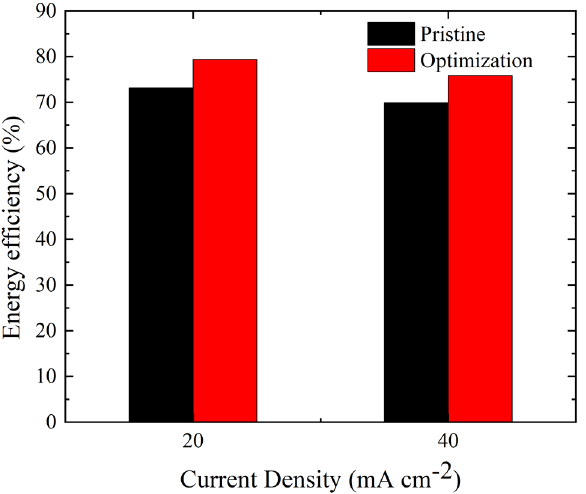
Figure 18. Comparison of energy e ffi ciency of ba tt ery before and after optimization at di ff erent cur- rent densities.